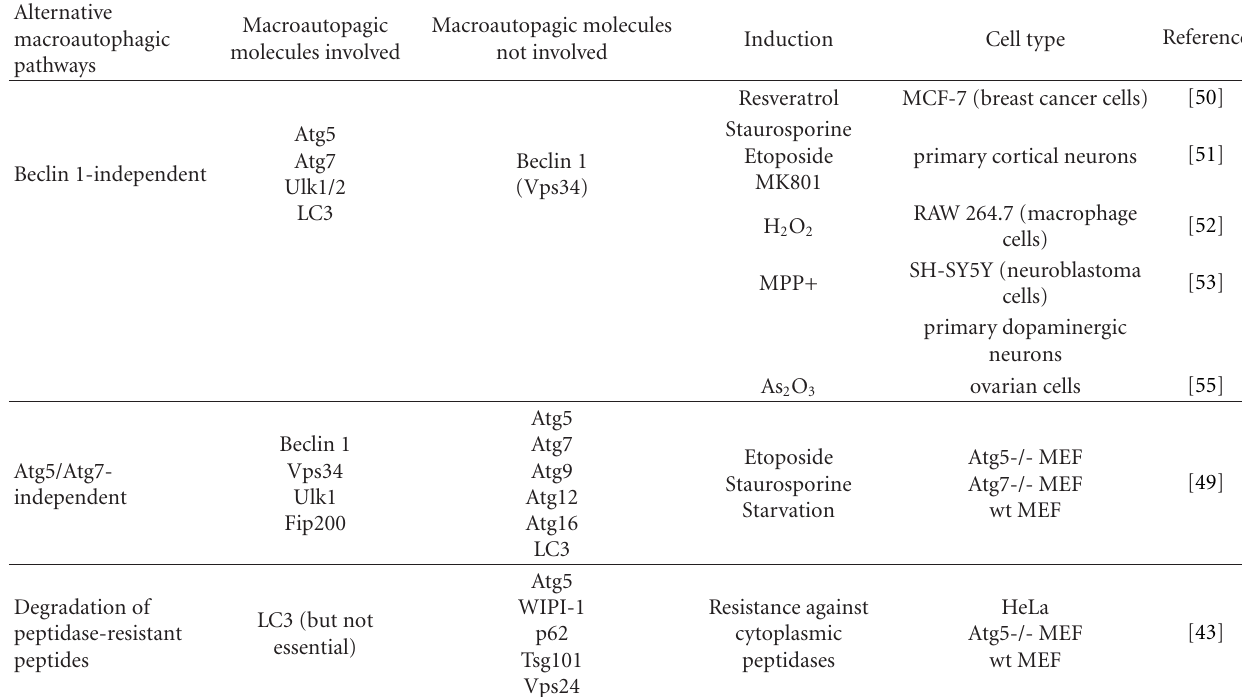
Table 1: Types of alternative macroautophagic